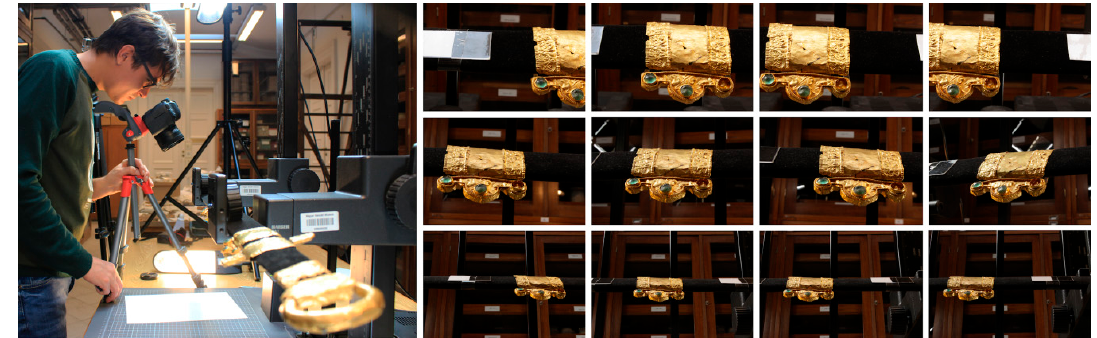
Figure 26. Photographic campaign on the Kunàgota sword and image sequence for 3D modeling with SFM techniques.